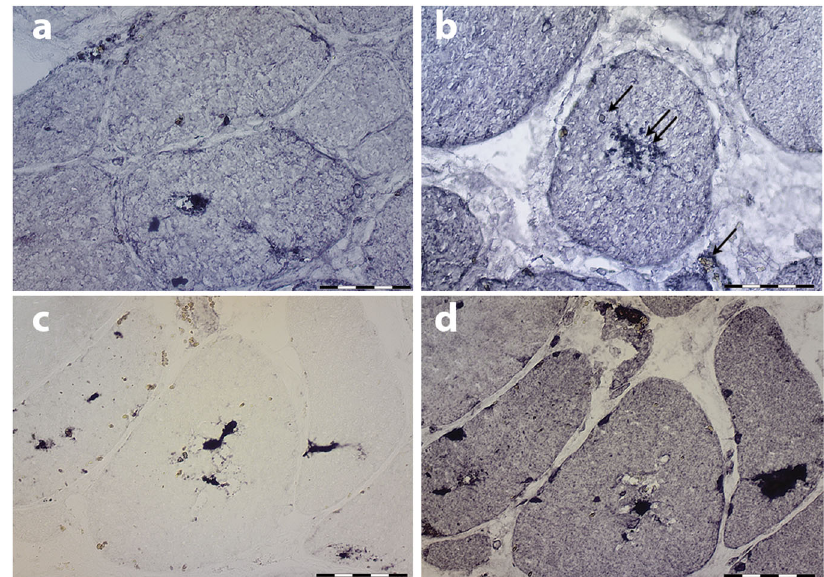
Fig. 4 Immunohistochemical features of myoglobinopathy. a , b Small myoglobin aggregates are observed in some myo fi ber regions and in some sarcoplasmic bodies (double arrow in b ), but not in others (arrow in b ). c p62 and ubiquitin d immunoreactivity is observed in some myo fi ber regions, and in some, but not in all sarcoplasmic bodies indicating protein aggregates. Scale bars = 20 µ